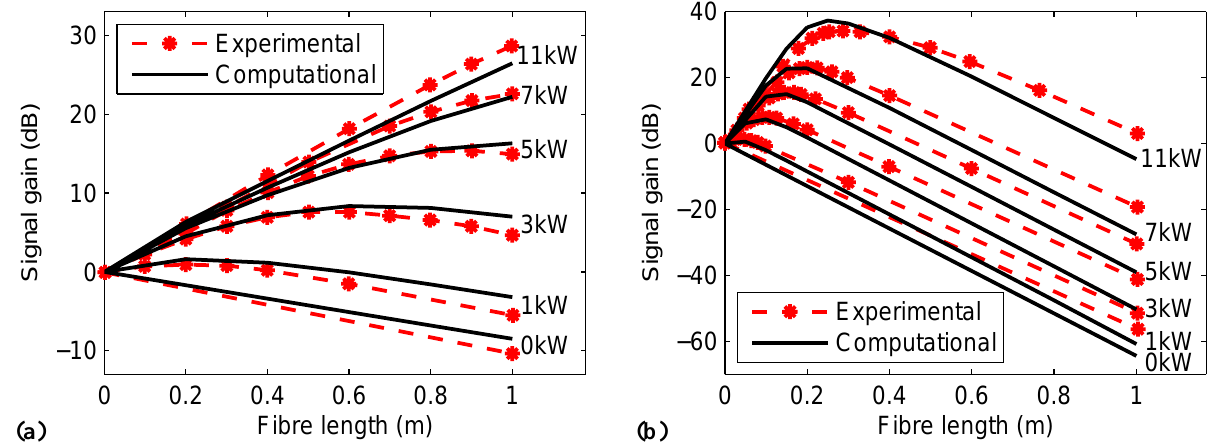
Figure 12. Evolution with distance of the signal gain at 591 nm for two different concentrations. Parameters as in Table 2, with γ = 1.43 and NA